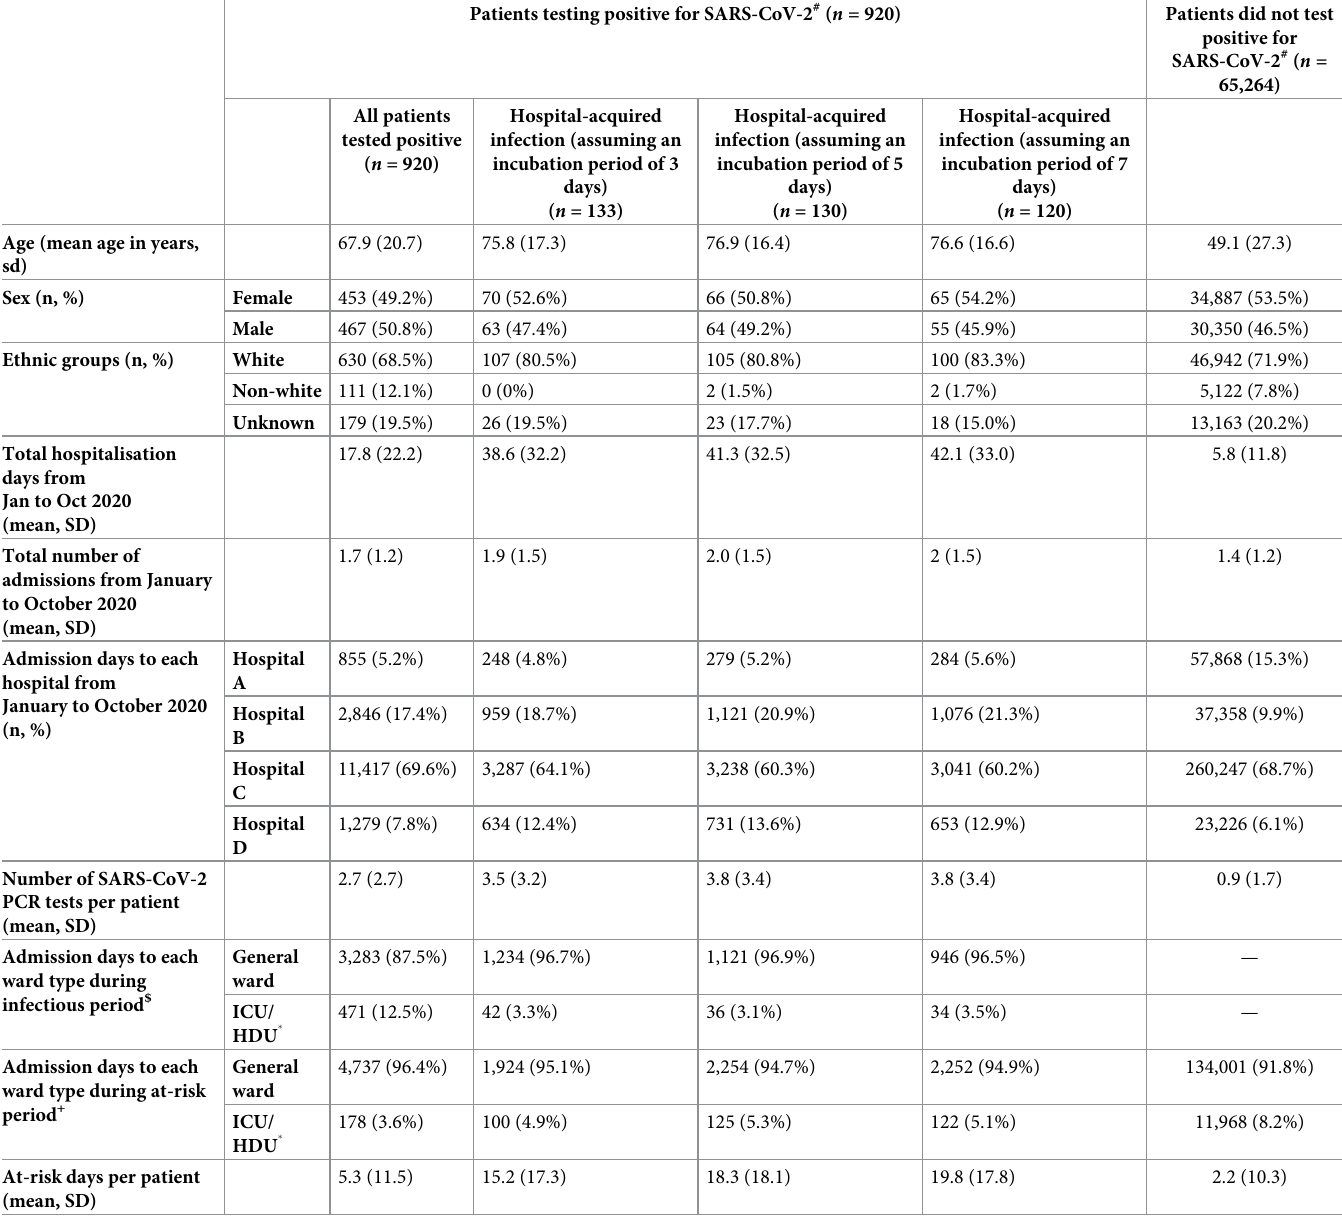
Table 1. Characteristics of the patients included in the